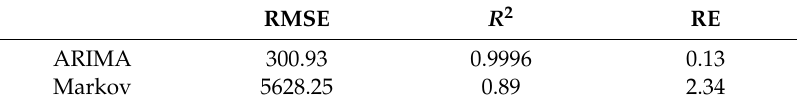
Table 8. Prediction error of the training set at monitoring point 2.